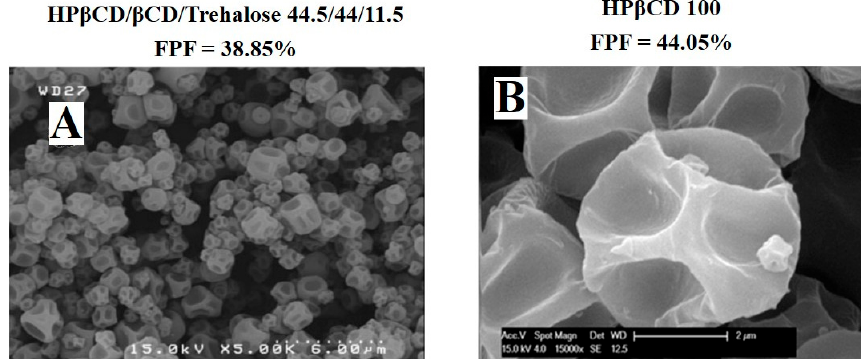
Figure 9. Scanning electron microscopy images of composite-corrugated particles showing rough surfaces. ( A ). Morphology 40), of microparticles composed of HP β CD, β CD, and trehalose (ratio 44.5 / 44 / 11.5), reproduced with permission from [25], published by Drug Development and Industrial Pharmacy, 2017. ( B ). Morphology of microparticles composed of 100% HP β CD reproduced with permission from [29], published by International Journal of Pharmaceutics, 2015.